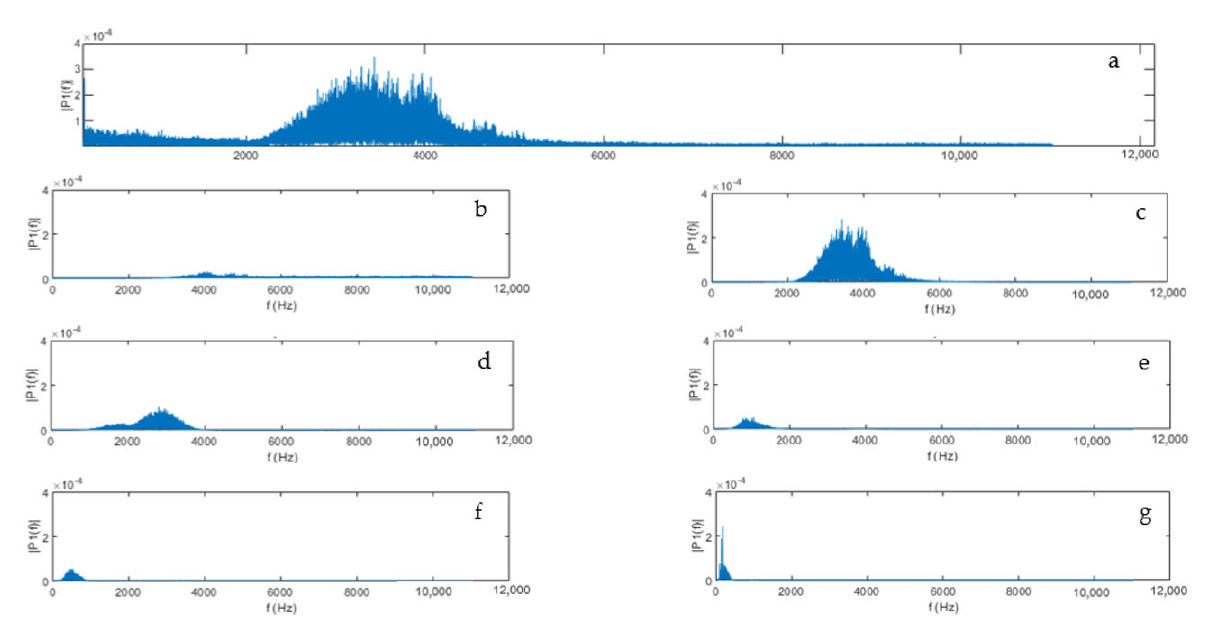
Figure 4. Single-sided amplitude spectrum of original signal ( a ) and decompositions 1–6 ( b – g ). Decomposition 2 ( c ) refers to bird vocalization, decomposition 4 ( e ) refers to fan.